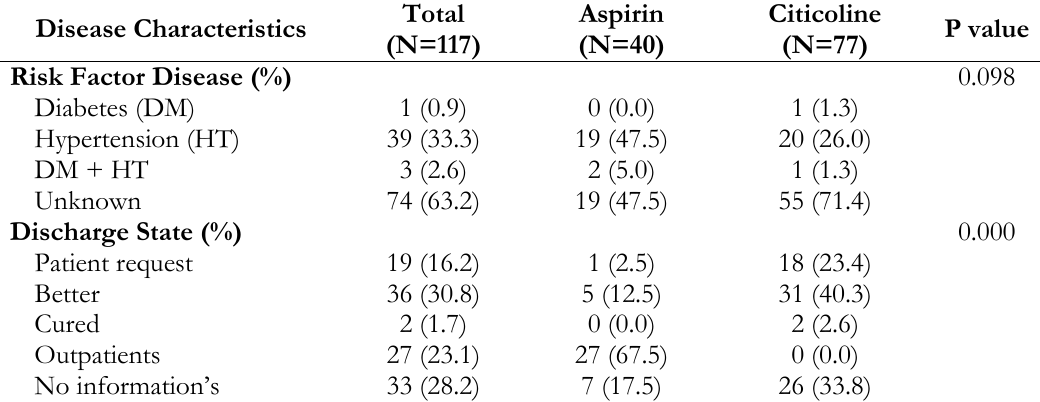
Table II. Disease characteristics of stroke patients Disease Characteristics